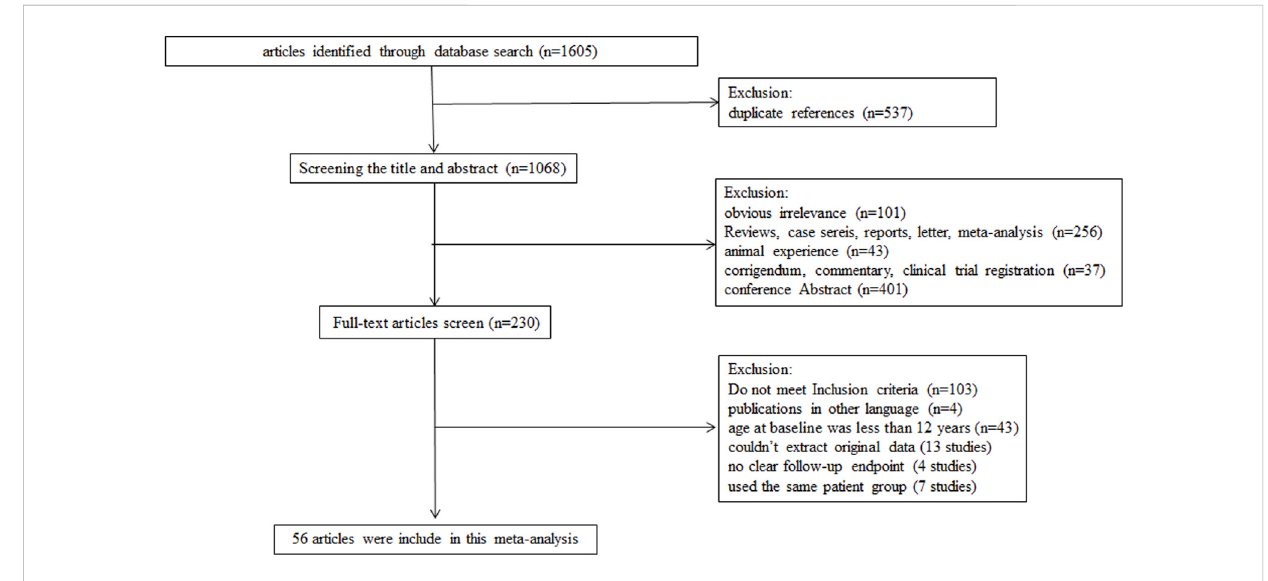
FIGURE 1 Flow diagram of study